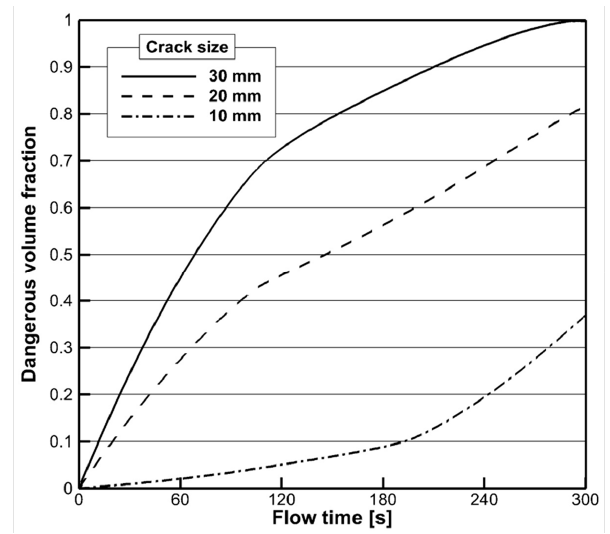
Figure 9. Dangerous volume fraction with time in the container.